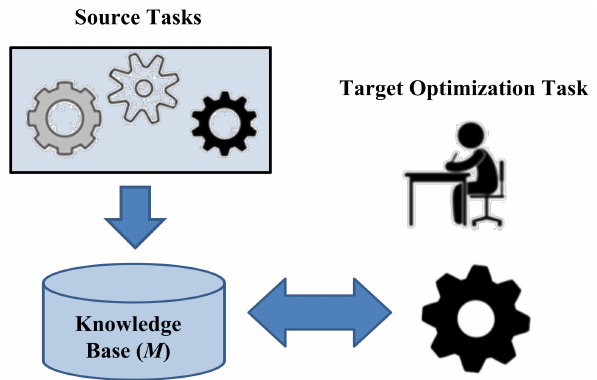
Figure 3. An illustration of a sequential transfer optimization problem